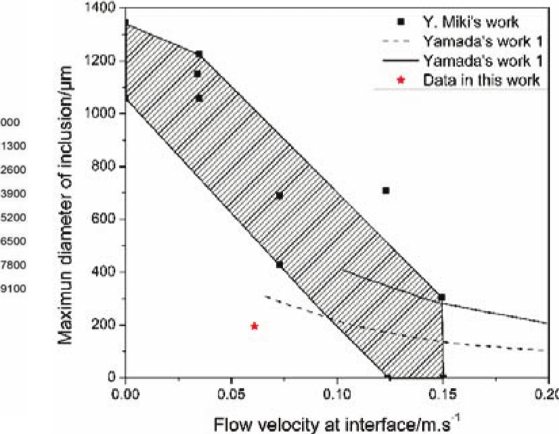
Figure 5: Relationship between the molten steel velocity and max- imum diameter of the entrapped